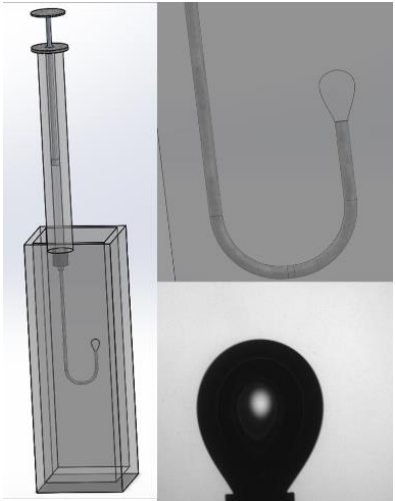
Figure 26. Rising drop formed upward at the tip of a U-bend.